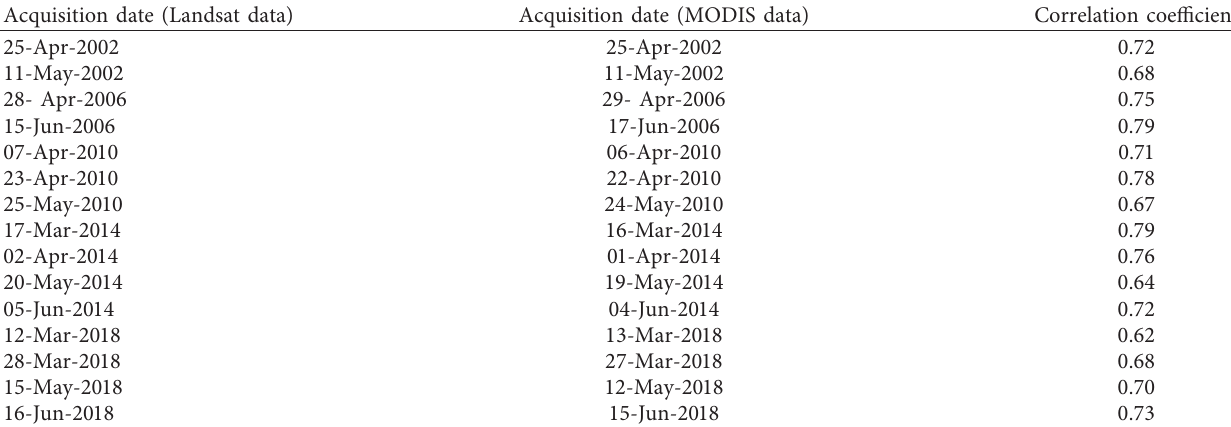
Table 4: Correlation coefficients between Landsat and MODIS sensors derived mean LST.